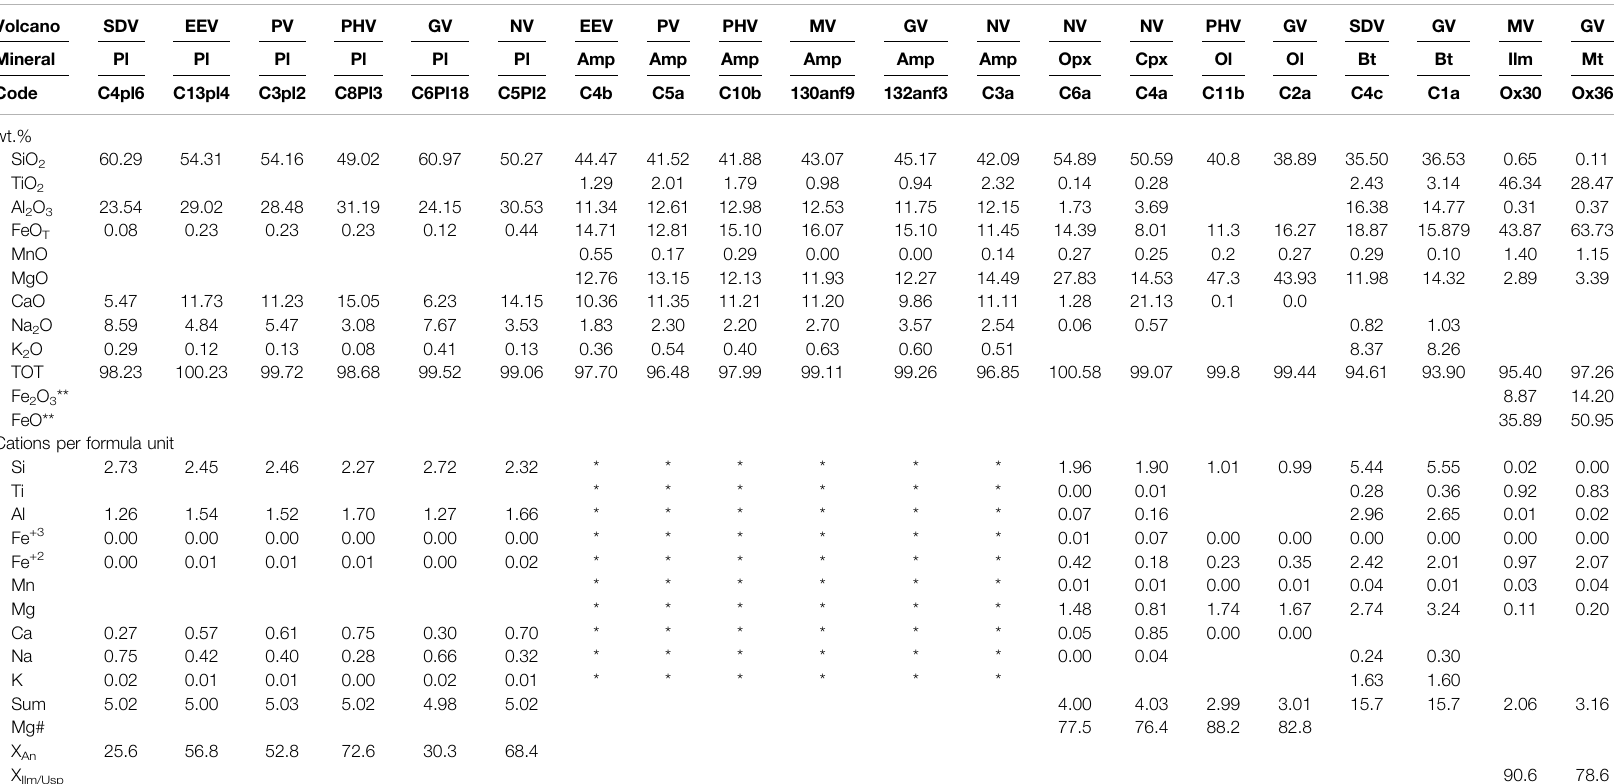
TABLE 2 | Representative mineral chemistry analyses from rocks of the Samaná monogenetic volcanic fi eld. Abbreviations: SDV, San Diego volcano; EEV, El Escondido volcano; PV, Piamonte volcano; PHV, Pela Huevos volcano; GV, Guadalupe volcano; NV, Norcasia volcano; MV, Morrón volcano; Pl, plagioclase; Amp, Amphibole; Opx, Orthopyroxene; Cpx, clinopyroxene; Ol, olivine; Bt, biotite; Ilm, ilmenite; Mt, magnetite; and Usp, ulvospinel.